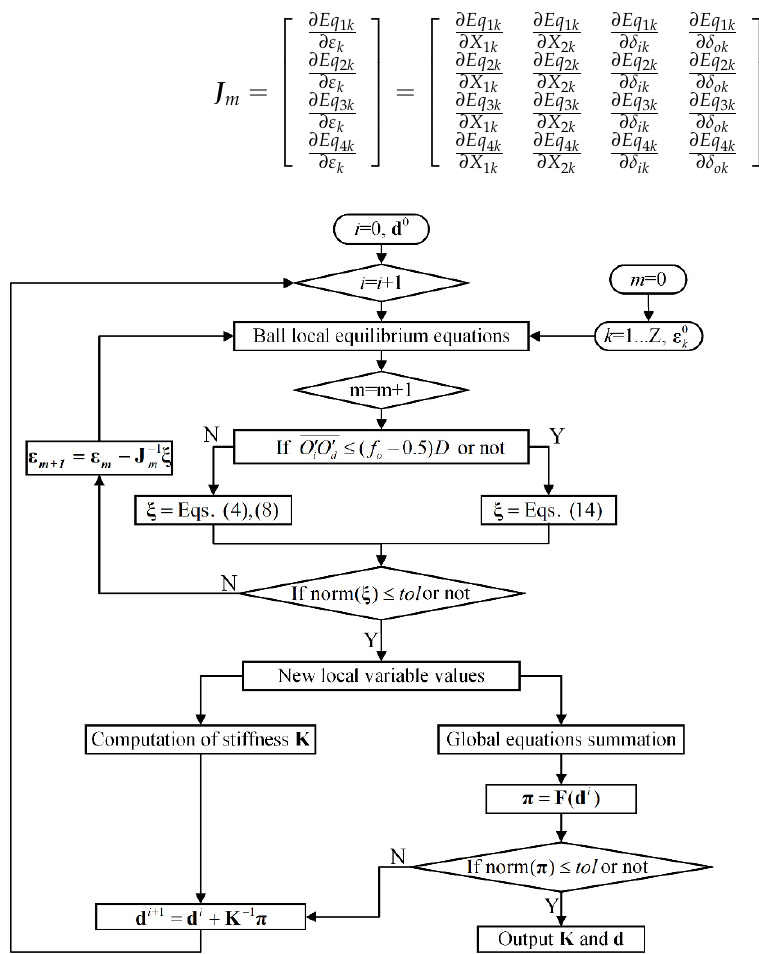
Figure 4. Calculation flow of proposed model, including the internal iteration of balls and the external iteration of bearing ring.